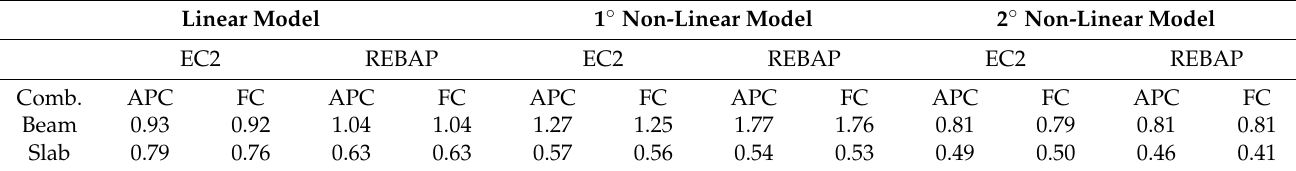
Table 7. Deformation ratios from LM, 1NLM and 2NLM for the first case of study.